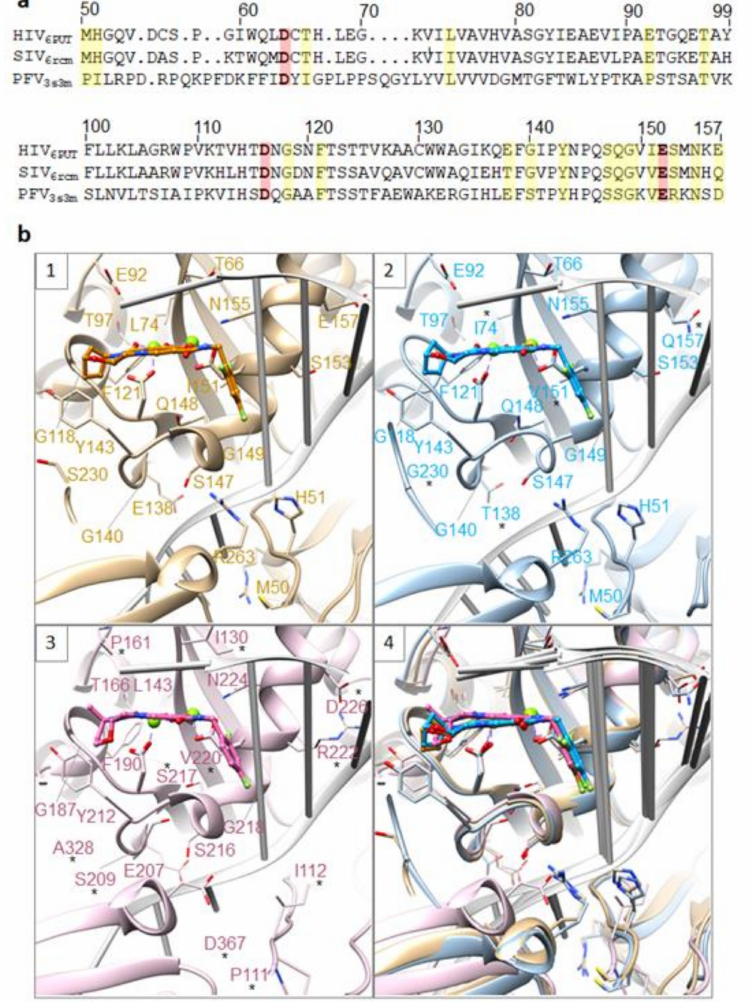
Figure 7. Comparison of HIV-1, SIV, and PFV intasomes. ( a ) Structure-guided alignment of the INs from HIV-1 (PDB ID: 6PUT), SIV rcm (6rcm), and PFV (3s3m), spanning HIV-1 IN residues M50- E157. Yellow stripes depict HIV IN residues, and the corresponding homologs in SIV and PFV, that are involved in drug resistance. Red stripes highlight the catalytic DDE triad responsible for IN enzymatic activity. ( b ) Comparison of the catalytic cores of HIV-1 IN (6put, first panel in tan), SIV rcm (6rcm, second panel in blue), and PFV (3s3m, third panel in pink) showing 20 residues that are involved in HIV drug resistance. All three structures are superimposed in the fourth panel. In the second and third panel, residues that are not conserved when HIV-1 IN is compared with either SIV rcm IN (second panel) or PFV IN (third panel) are labeled with a